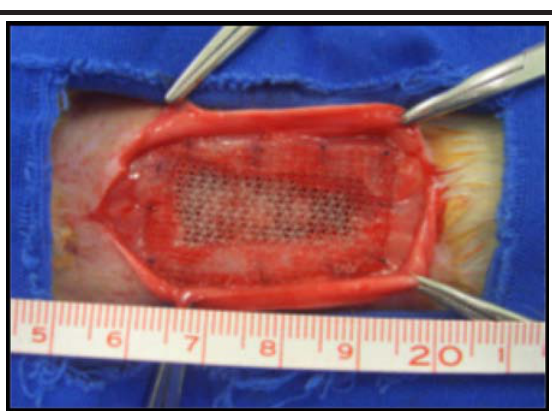
FIGURE 2 - Abdominal wall after muscle resection and production of deformity to be corrected later by one of the meshes.